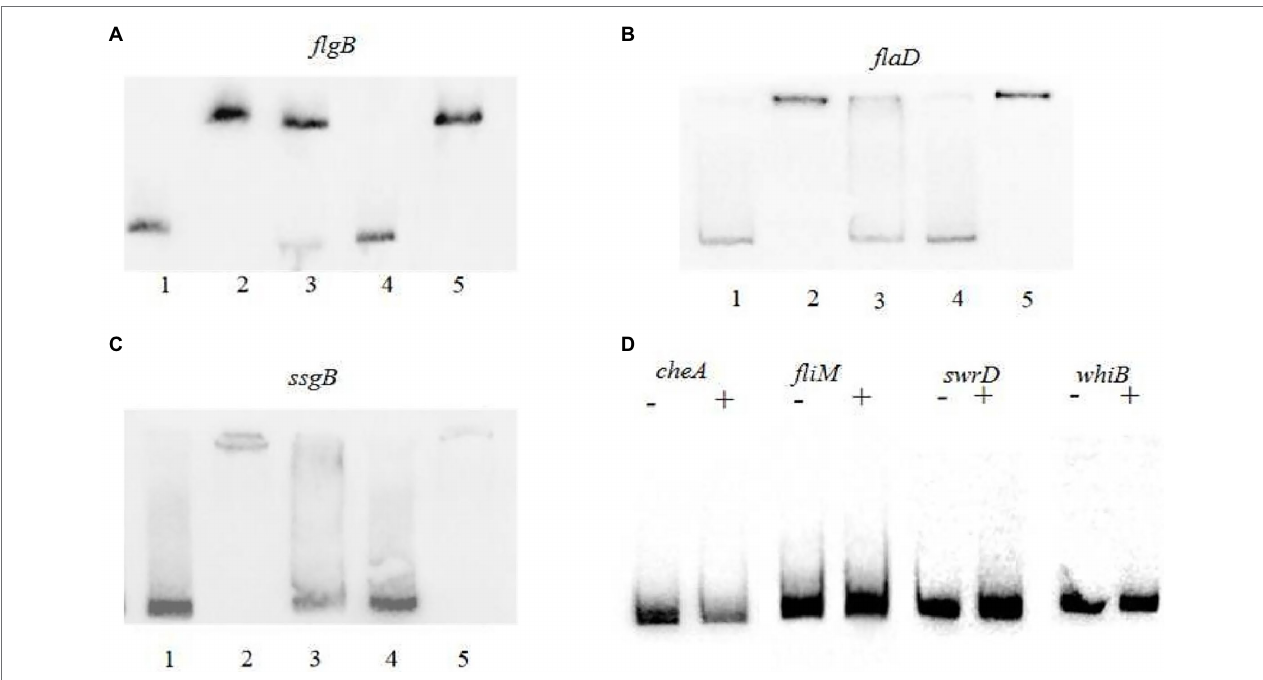
FIGURE 4 | EMSAs with PhoP protein of A. pretiosum X47. (A–C) Binding of PhoP with the upstream sequences of flgB (A) , flaD (B) , and ssgB (C) . The probes were incubated with no protein (lane 1), 1.0 μ g protein (lane 2), 1.0 μ g protein (lanes 3–5), 50-fold excess of unlabeled specific probe (lane 3), 200-fold excess of unlabeled specific probe (lane 4), and 200-fold excess of unlabeled unspecific probe (lane 5). (D) Binding of PhoP with the upstream sequences of cheA , fliM , swrD , and whiB . The probes were incubated with no protein ( − ) or 4 μ g protein (+).